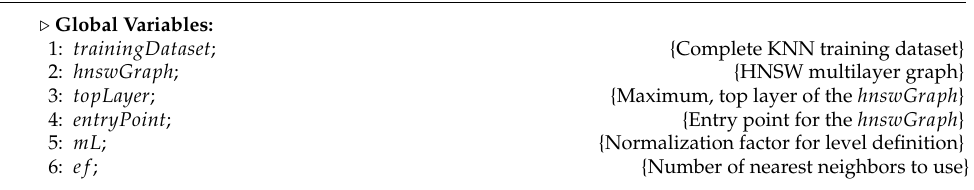
Algorithm 1: HNSW graph generation and search